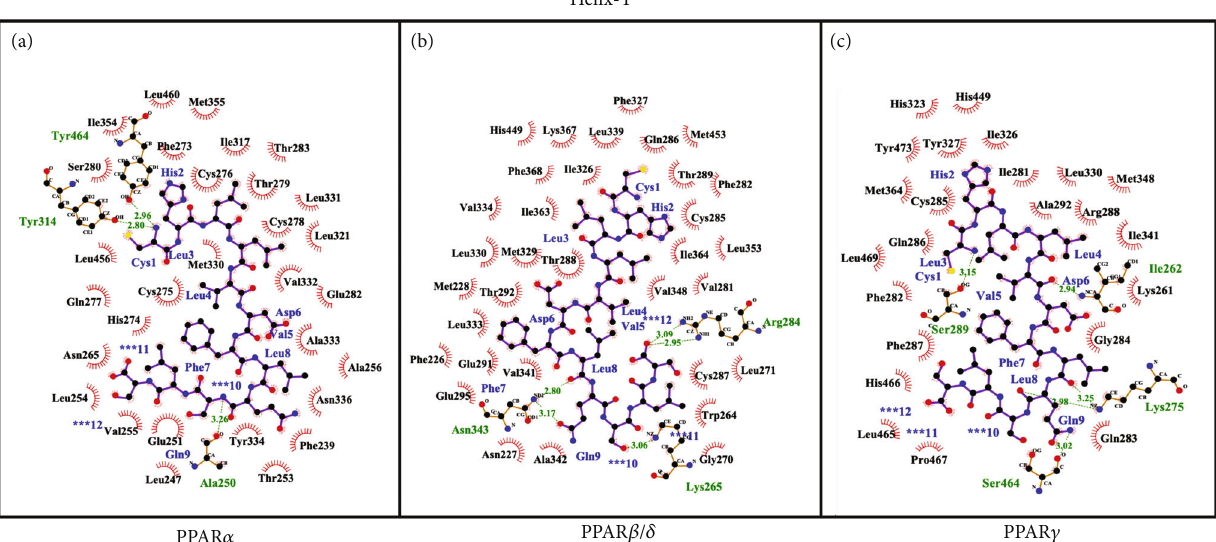
Figure 8: Interatomic interaction of peptide Helix-Y 12 (label in blue) with (a) PPAR α , (b) PPAR β / δ , and (c) PPAR γ . Hydrogen bonds are indicated with green label and hydrophobic forces in black